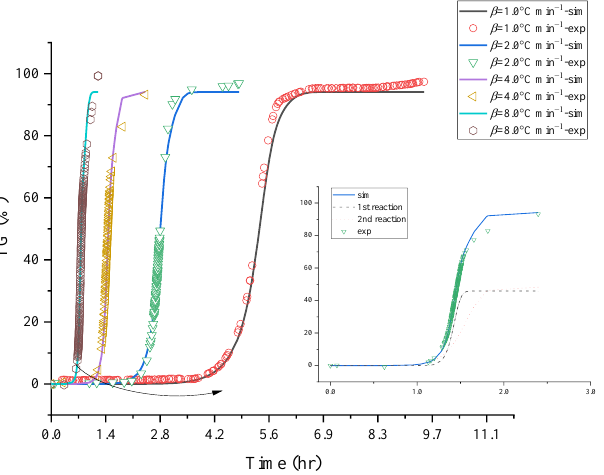
Figure 3. Comparisons of [BZMIM][TF2N]’s mass loss (top) and mass loss rate (bottom) vs. time curves at heating rates of 1.0, 2.0, 4.0, and 8.0 °C min −1 by experiments and simulations.